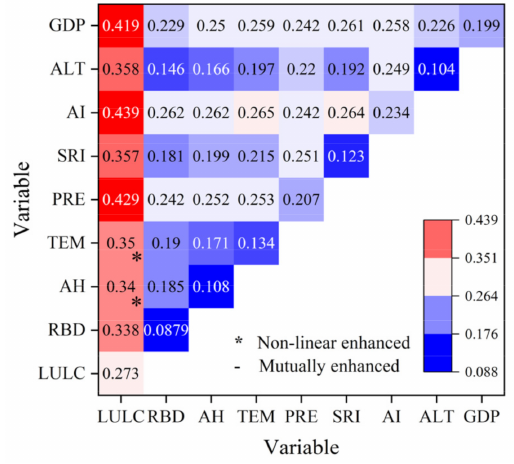
Figure 8. Result matrix of interactions between